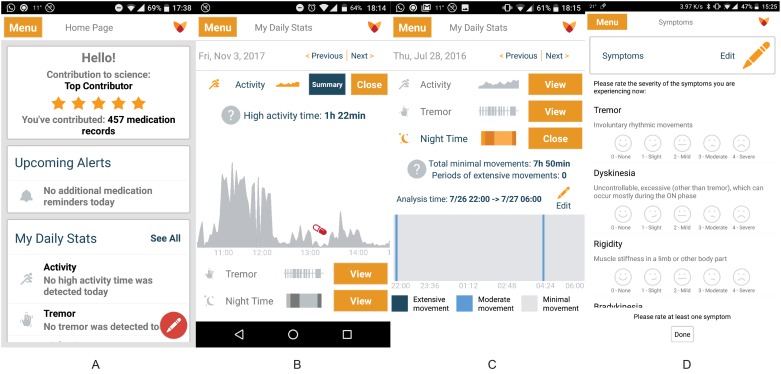
(a) Fox Wearable Companion app main screen; (b) Fox Wearable Companion app activity graph; (c) Fox Wearable Companion app movement during sleep graph; (d) Fox Wearable Companion app symptom self-reports.“Reprinted from [Intel and Michael J Fox Foundation] under a CC BY license, with permission from [INTEL®], original copyright [2017].